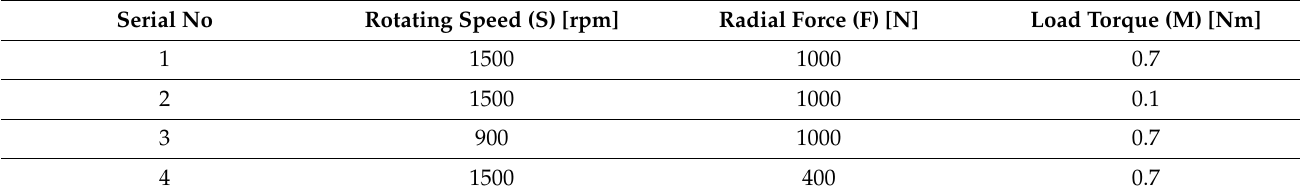
Table 2. Working conditions of the KAT-bearing testbed.